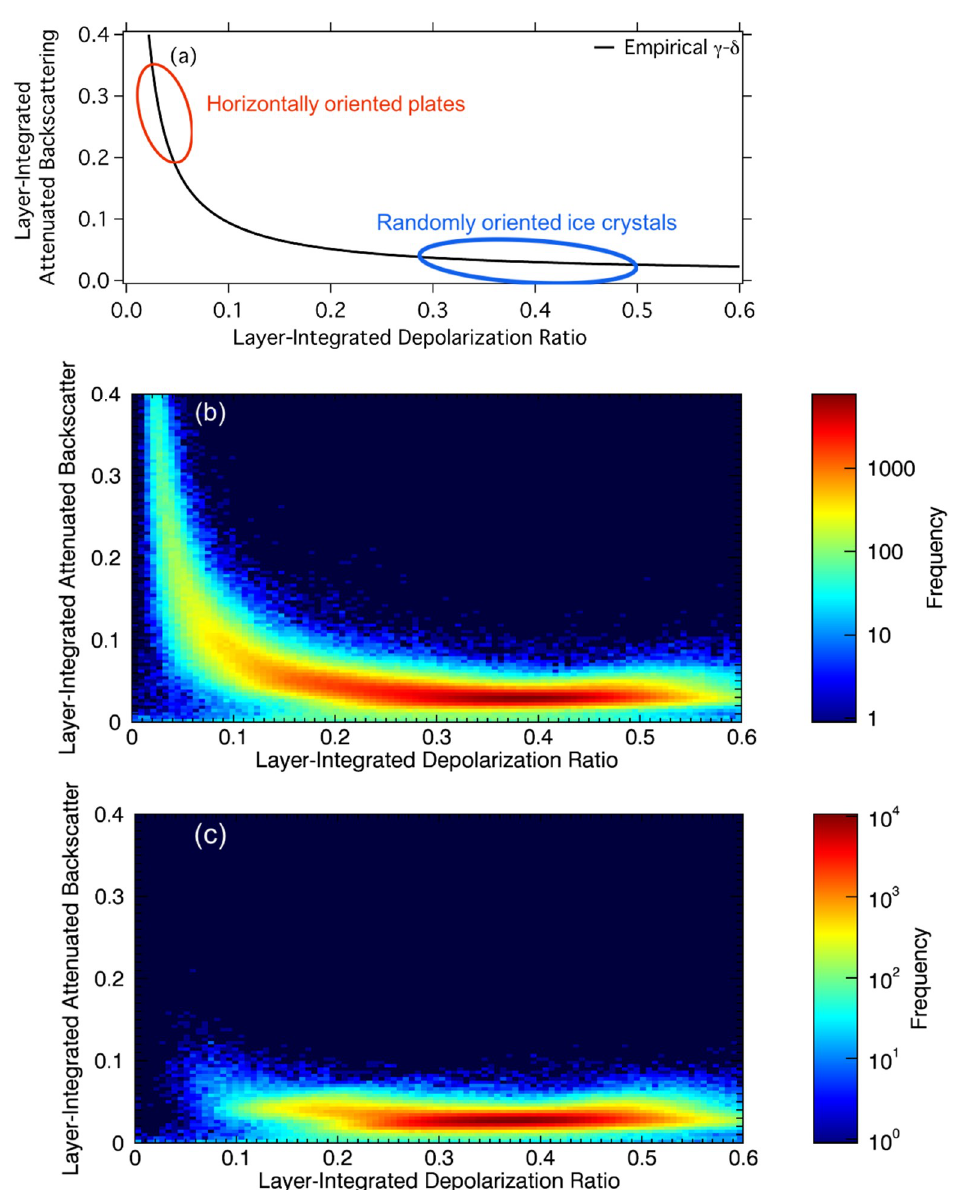
Figure 6. ( a ) Schematic diagram illustrating the relation between the layer-integrated backscatter ( γ ) and the layer-integrated depolarization ( δ ) associated with ice clouds; ( b ) ice cloud γ - δ relation observations made by CALIOP during April 2007 when the CALIOP lidar was in nadir-viewing configuration; and ( c ) ice cloud γ - δ relation observations made by CALIOP during April 2009 when the CALIOP lidar pointed 3° off nadir.